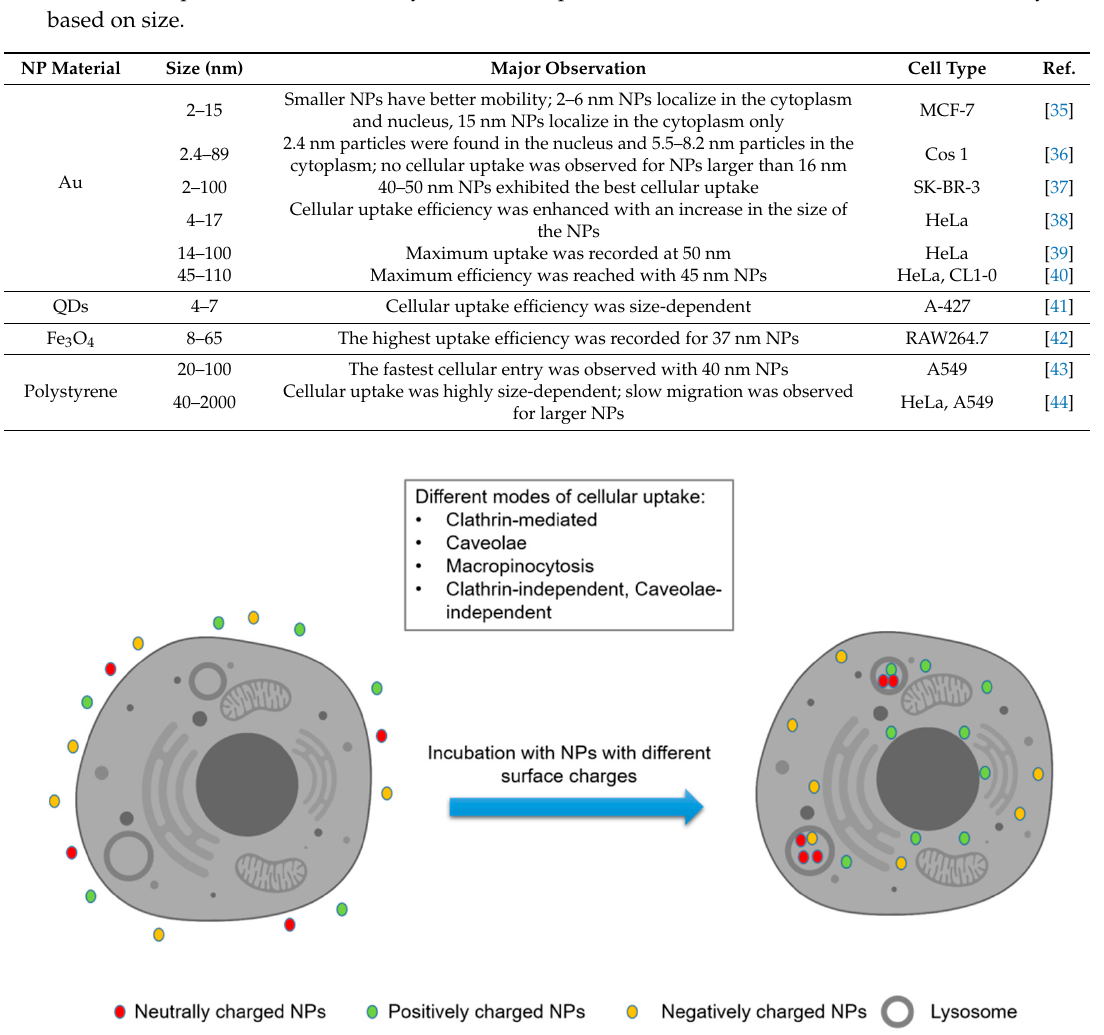
Figure 1. Cellular uptake of NPs with different surface charges.